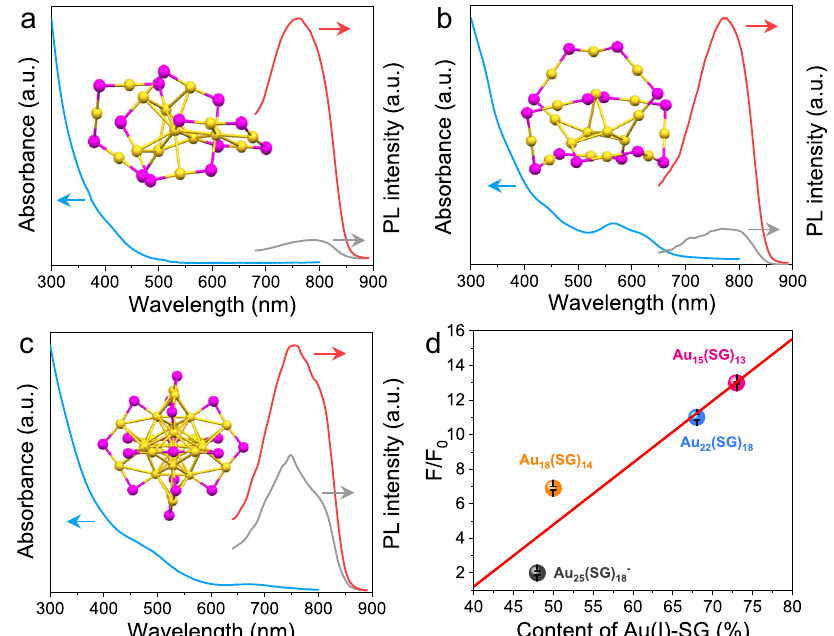
Fig. 6 PDA-triggered luminescence enhancement of other types of gold NCs. a UV-vis absorption spectrum of Au 15 (SG) 13 (blue line), and photoemission spectra of Au 15 (SG) 13 (gray line) and PDA-Au 15 (SG) 13 (red line) NCs. Inset shows the Au-S framework of Au 15 (SR) 13 (drawn according to the reported structure 60 ). The yellow spheres represent Au atoms, and the purple spheres represent S atoms. a.u. arbitrary units. b UV-vis absorption spectrum of Au 18 (SG) 14 (blue line), and photoemission spectra of Au 18 (SG) 14 (gray line) and PDA-Au 18 (SG) 14 (red line) NCs. Inset shows the Au-S framework of Au 18 (SR) 14 (drawn according to the reported structure 61 ). a.u. arbitrary units. c UV-vis absorption spectrum of Au 25 (SG) 18 − (blue line), and photoemission spectra of Au 25 (SG) 18 − (gray line) and PDA-Au 25 (SG) 18 − (red line) NCs. Inset shows the Au-S framework of Au 25 (SR) 18 − (drawn according to the reported structure 62 ). a.u. arbitrary units. d Effect of the content of surface-bound Au(I)-SG complexes on the PDA-induced luminescence enhancement of gold NCs. F 0 and F represent the luminescence intensity of gold NCs at their maximum emission wavelengths in the absence and presence of PDA, respectively. Error bars represent standard deviation over three independent